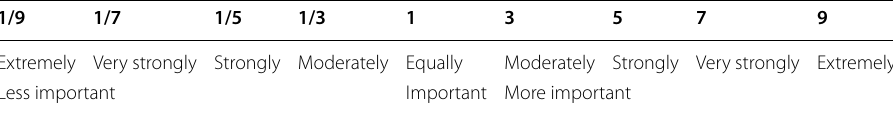
Table 2 Comparison scale of relative weights for pairwise comparisons (Lu et al. 2019a; Saaty 1977) 1/9 1/7 1/5